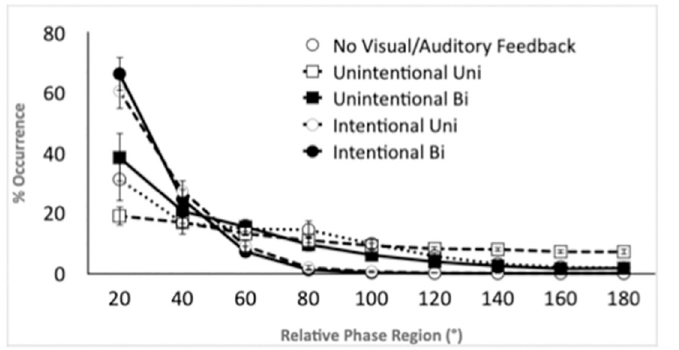
Fig 5. Distributions of relative phase angles of the robot and human arm’s